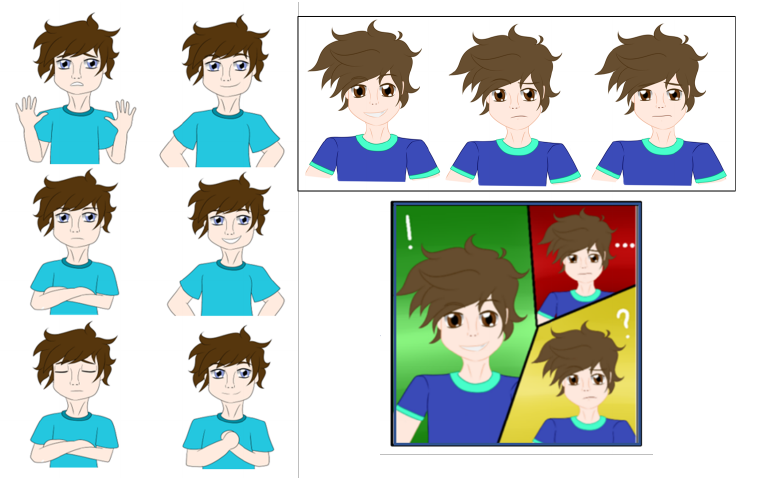
Figure 4. Different visualizations of emotions through facial expressions, background color and punctuation marks. The avatar expressions represent the student’s emotions based on the model predictions. A main challenge is to ensure that students can accurately perceive the visualized emotion and understand (empathize) why their future self is visualized with a given